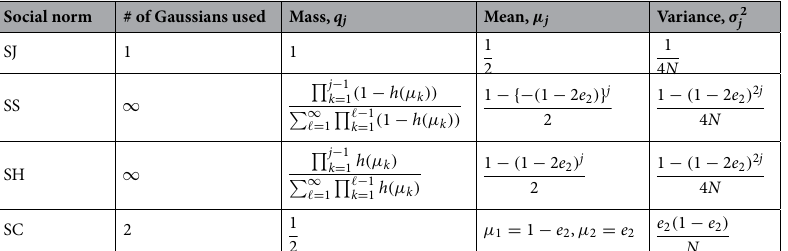
Table 3. Analytical solutions to Eq. (19). h is defined as h ( p ) 0 1 . From this table, we see that, for SJ norm, neither the error rate in action e 1 nor the the convention, 1 · = k = error rate in assessment e 2 influences the stationary distribution. For SS and SH, e 1 influences only masses q j , (cid:31) and e 2 influences masses q j , means µ j , and variances σ 2 j . For SC, e 1 influences nothing, but e 2 influences means µ j and variances σ 2 j